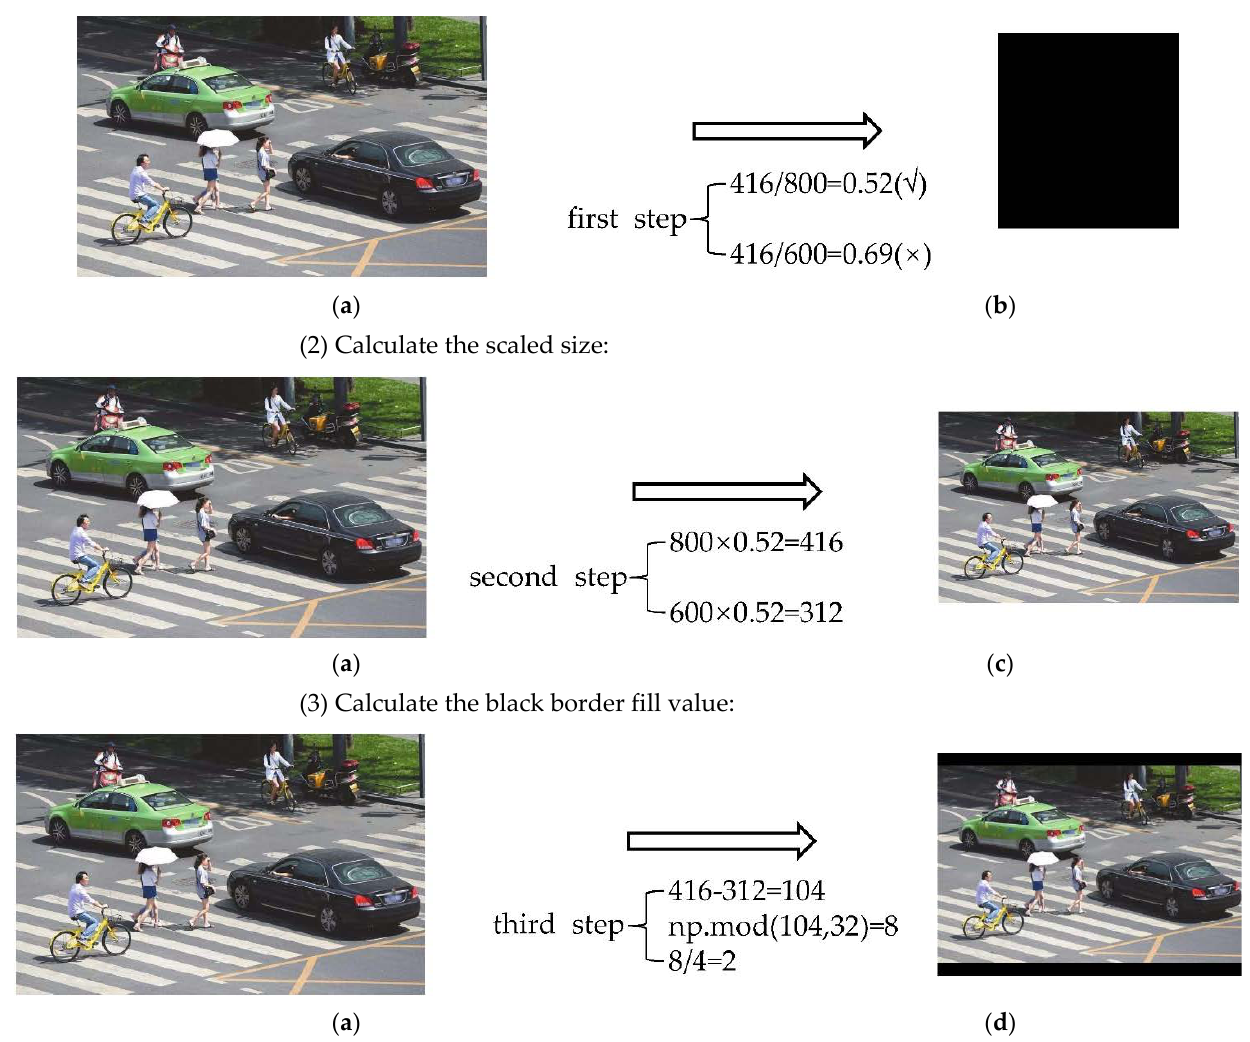
Figure 5. Improved image scaling method. ( a ) Weight × height: 800 × 600; ( b ) weight × height: 416 × 416; ( c ) weight × height: 416 × 312; ( d ) weight × height: 416 × 320 (312 + 4 + 4).